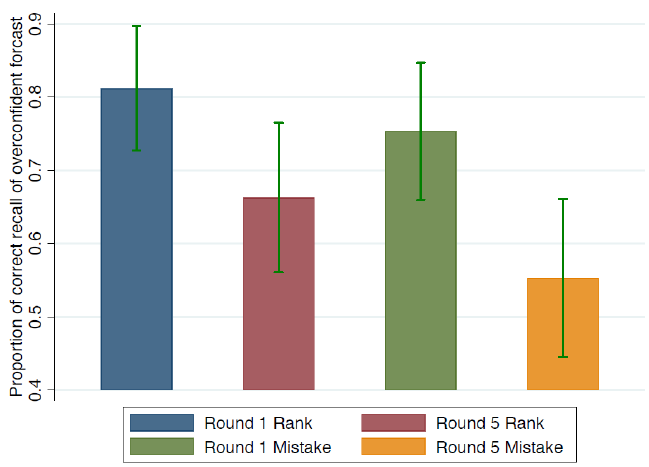
Figure 4. Proportion of Correct Recall of Overconfident Forecasts.